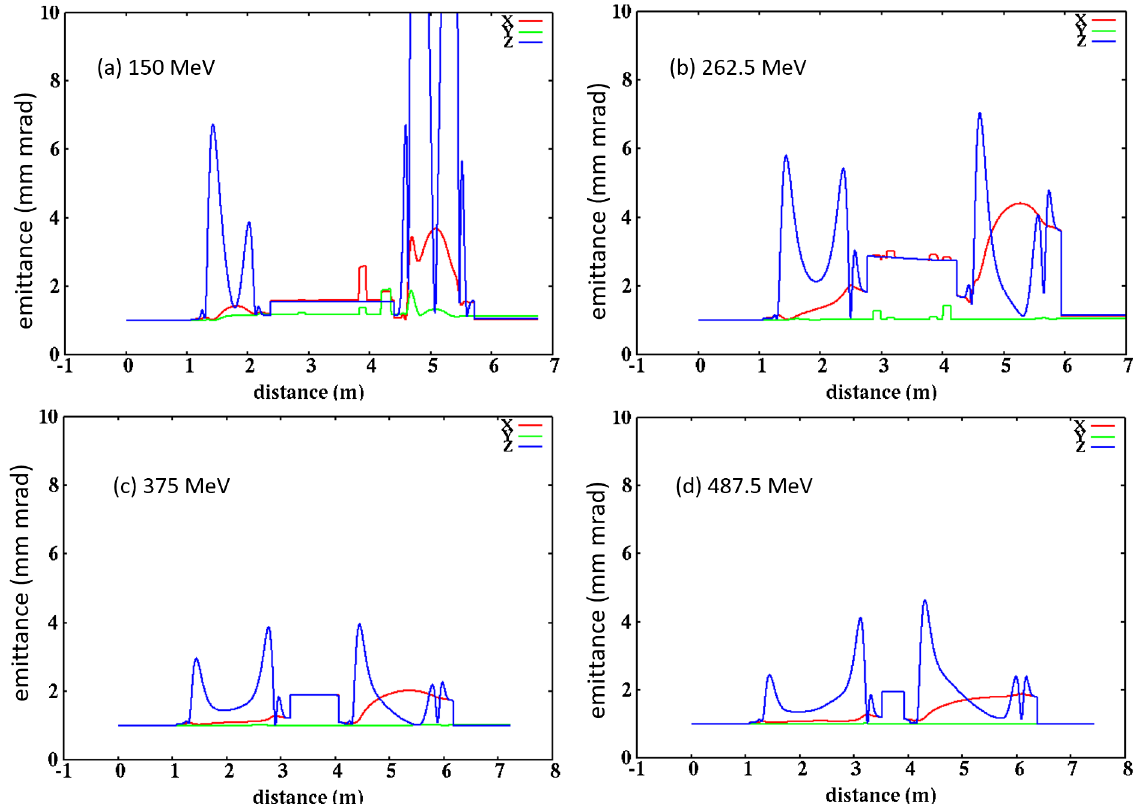
FIG. 11. Proton beam transverse and longitudinal RMS emittance evolution through the phase shifter (Table II) with 150 MeV (top left), 262.5 MeV (top right), 375 MeV (bottom left), 487.5 MeV (bottom right) kinetic energy, initial Waterbag distribution, and 40 mA